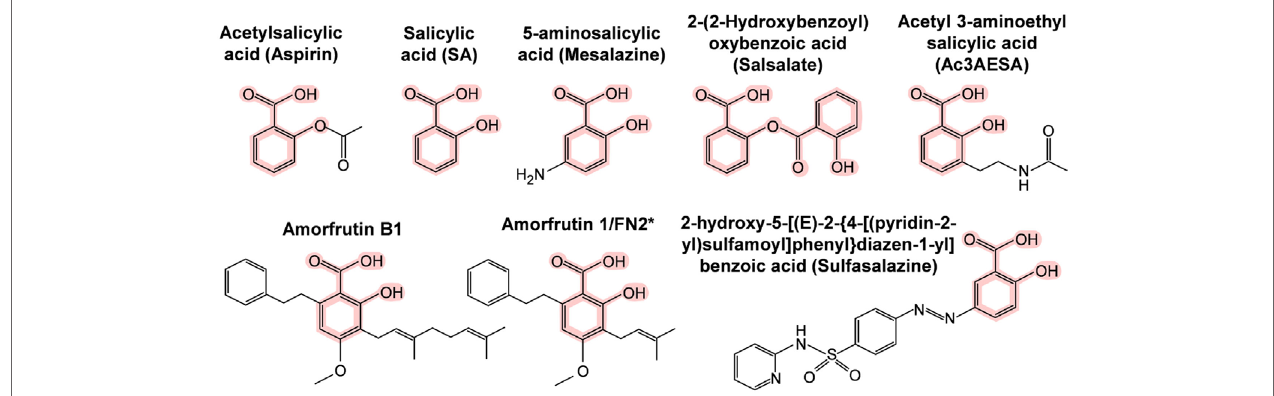
FiGURe 2 | Chemical structures of SA and its synthetic and natural derivatives . The SA core is highlighted in pink. *This amorfrutin was called amorfrutin 1 in Weidner et al. (17) and FN2 in Choi et al.